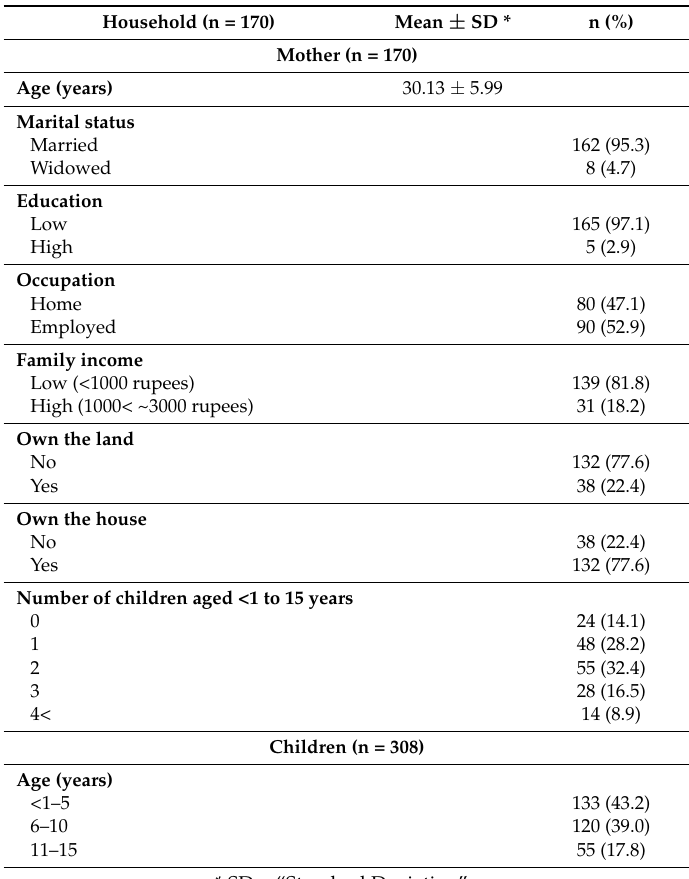
Table 1. Demographic and socioeconomic characteristics of study